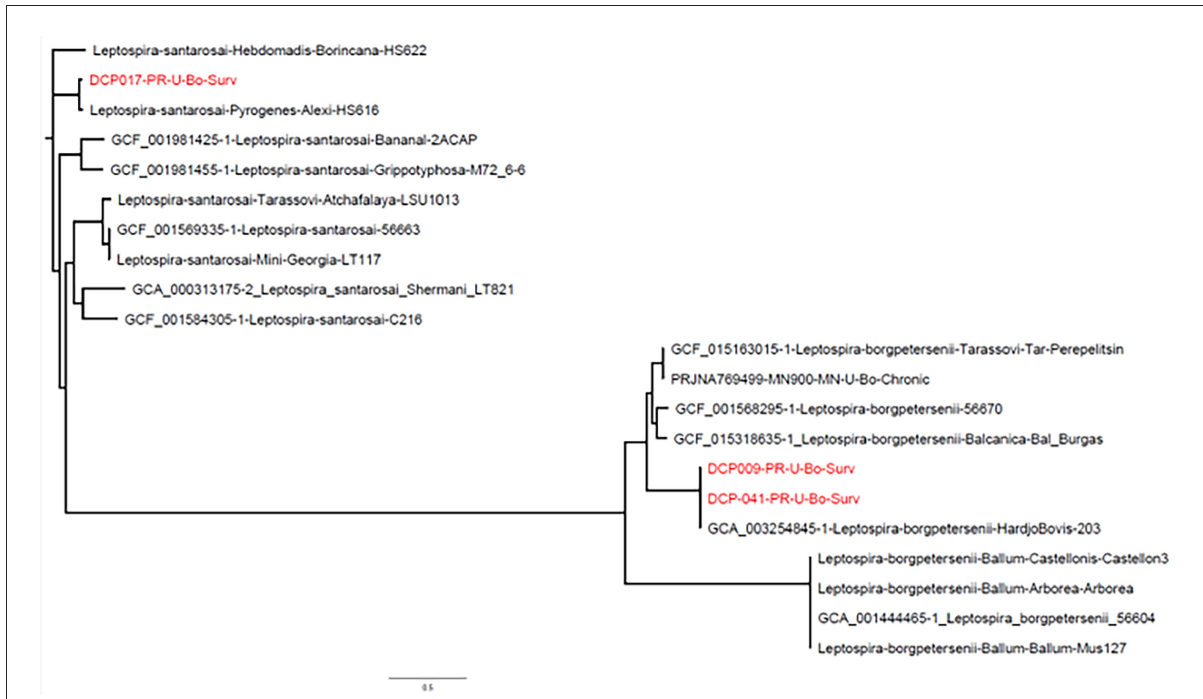
FIGURE2 Phylogeny of L. borgpetersenii strain DCP-009 and strain DCP-041 and L. santarosai strain DCP-017 based on complete whole genome sequence analysis. Genome sequences from GenBank are preceded by an accession number, while the NVSL in-house sequences are identified only by the species, serogroup, serovar, and strain.